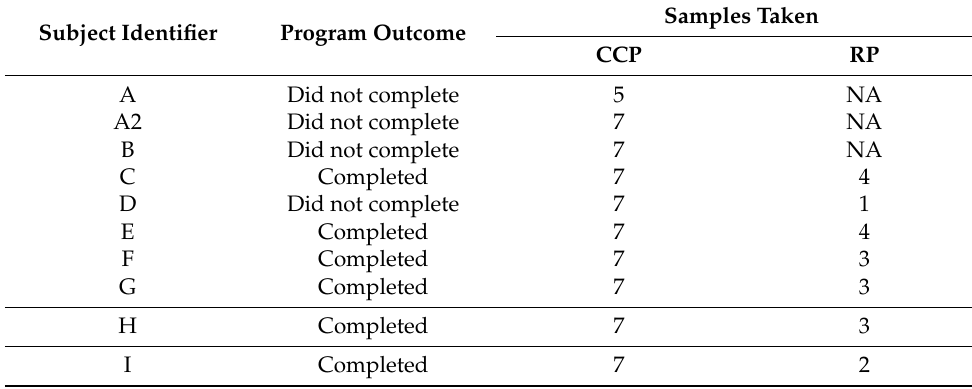
Table 4. Outcomes for equine enrolled in the refeeding